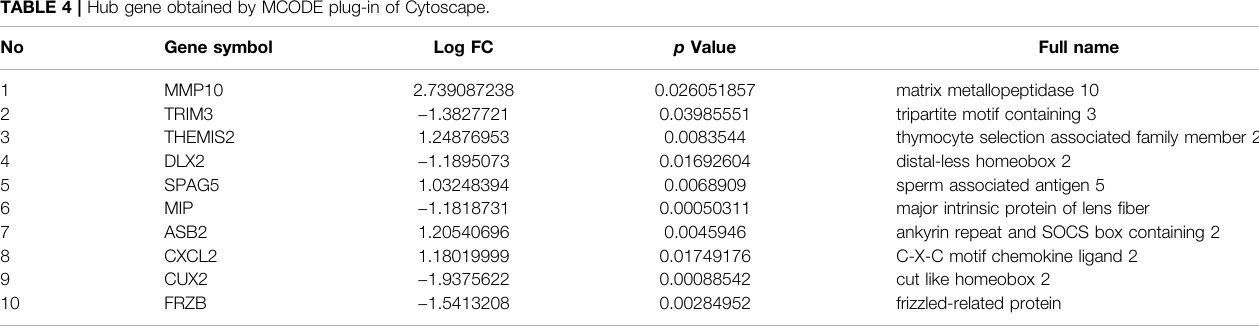
TABLE 4 | Hub gene obtained by MCODE plug-in of